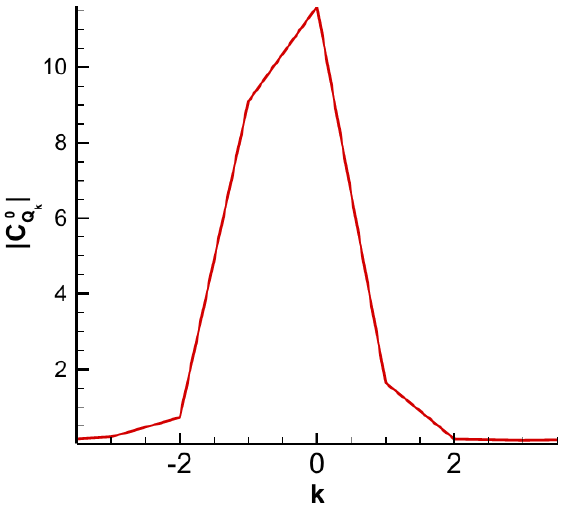
Figure 12. Schematic of the model to compute AICs.